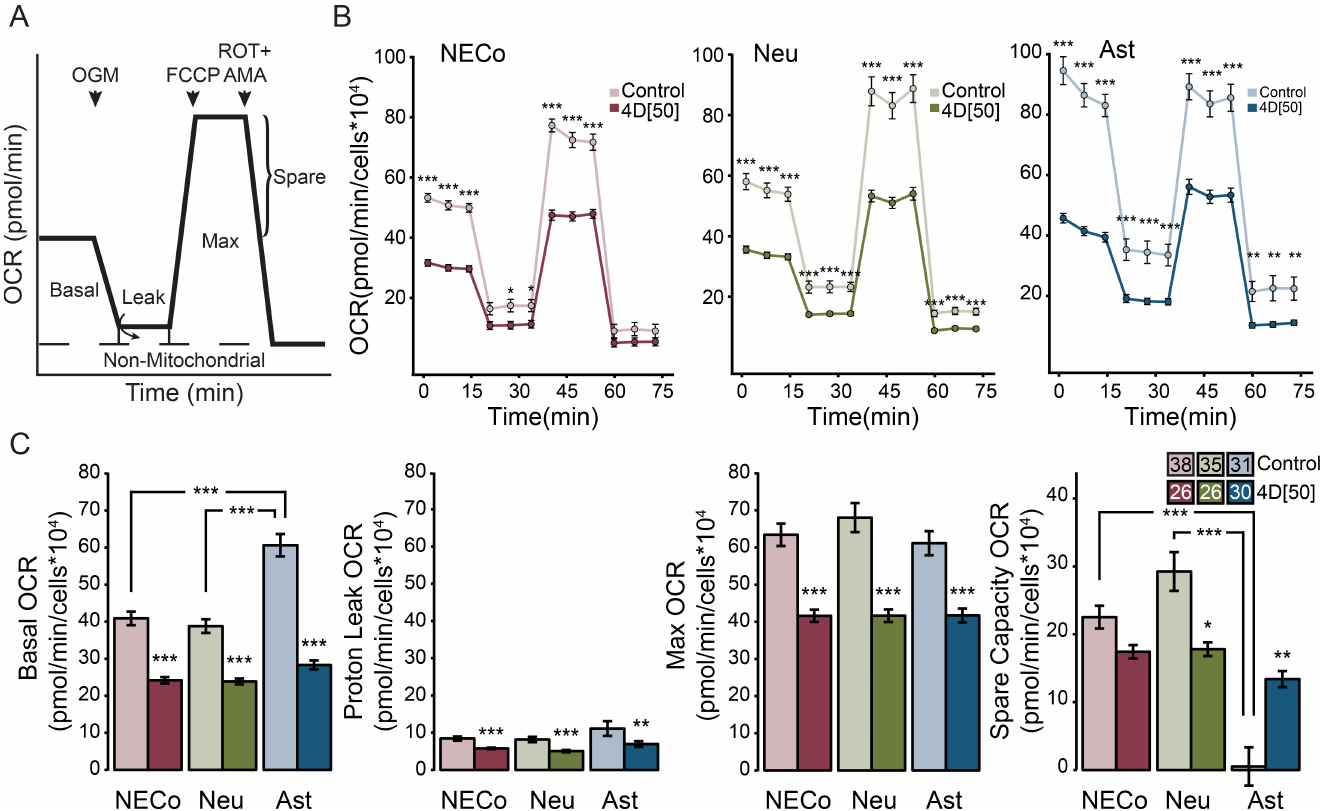
Fig 4. EtBr treatment reduces oxygen consumption and increasesmitochondrial spare capacity in astrocytes. (A) Diagramof the procedureand measurements of the Seahorseassay. The sequential additionof mitochondrial toxins permits the measurement of different respiratory states. After recordingbasal respiration, oligomycin(OGM) is added to block complex V and to eliminateATP production-linked oxygen consumption. Additionof FCCP allows the free flux of protons through the mitochondrial inner membraneand maximum oxygen consumption. Rotenoneand antimycin A (ROT +AMA) inhibit complex I and III, and prevent proton pumping. Non-mitochondrialresidual oxygen consumption is subtracted from all measurements. (B) Oxygen consumption rate (OCR) of NECos, neurons, and glia, in the presenceand absenceof EtBr. (C) Basal, leak, max, and spare capacity OCR of NECos, neurons, and astrocytes, in the presenceand absenceof EtBr. N for each group is includedin figure legends. Error bars reflect +/-SEM. *** = p < 0.001; ** = p < 0.01; * = p < 0.05, after Dunn’spost-hoc test.